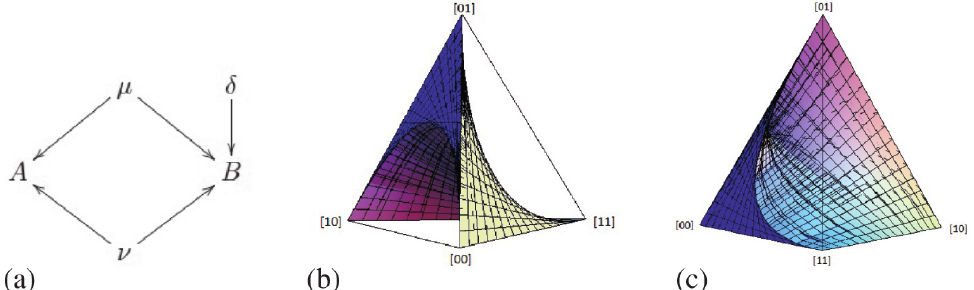
− u )(u u − u u )| ≤  u 10 11 00 10 01 11